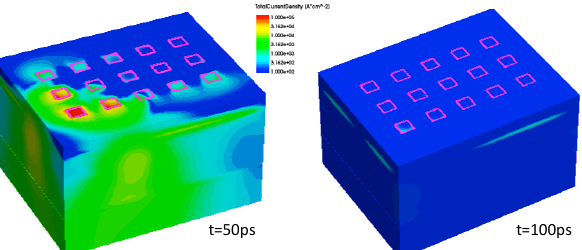
Fig. 16. Total current density at t=50ps (maximum of the generation) and t=100ps for the alpha particle.